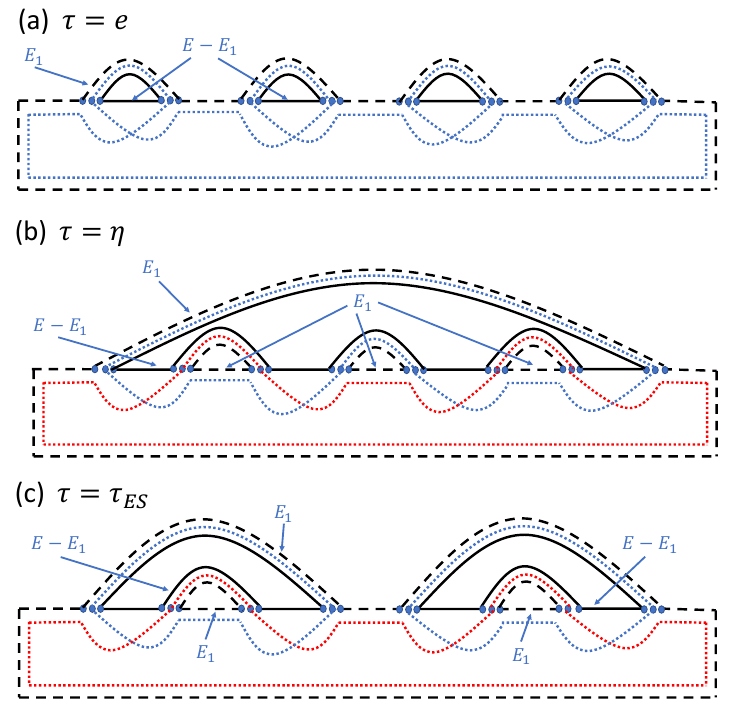
Figure 30 . Diagrams for different possible dominant contributions to Z (PT) n in the microcanonical ensemble with A at infinite temperature. Recall that dashed, dotted and solid lines respectively 2 represent A , A , B . In this example, all energies in A 1 2 and each of the energies in B gets set to E − E